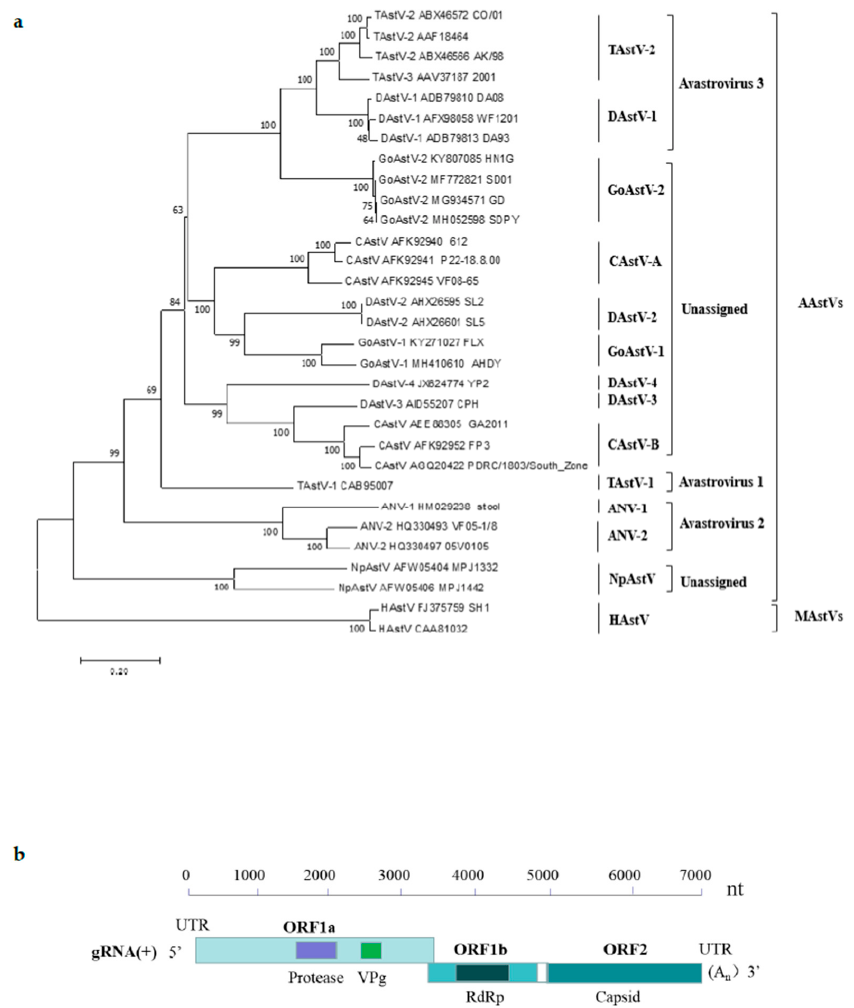
Figure 1. Phylogenetic tree of the amino acid sequences of astrovirus isolates based on the complete sequences of the capsid protein ( a ). All the reference sequences used in this study were obtained from the GenBank database. The tree was constructed by the neighbor-joining method with 1000 bootstrap replications using MEGA 7.0.14 software. Complete genome organizations of avian astroviruses ( b ). Nucleotide position of three ORFs in the genome is shown. ORF, open reading frame; VPg, viral genome-linked protein; RdRp, RNA- dependent RNA polymerase. Currently, there are no commercial drugs or vaccines available to treat and to prevent astroviruses in poultry. Therefore, good levels of biosecurity including accurate detection method, impeccable management system, strict quarantine and elimination will be effi- cient ways to control this virus. An extended interval between production cycles will help reduce the risk of the avian astrovirus infection [30]. Multiple age farming should be avoided to shed the virus, and poultry wastes should be collected and removed on a reg- ular basis in such a way that passages within the poultry facilities are free of contamina- tion. In addition, the prevention of renal injury is important for reducing the incidence of gout in goslings [31].